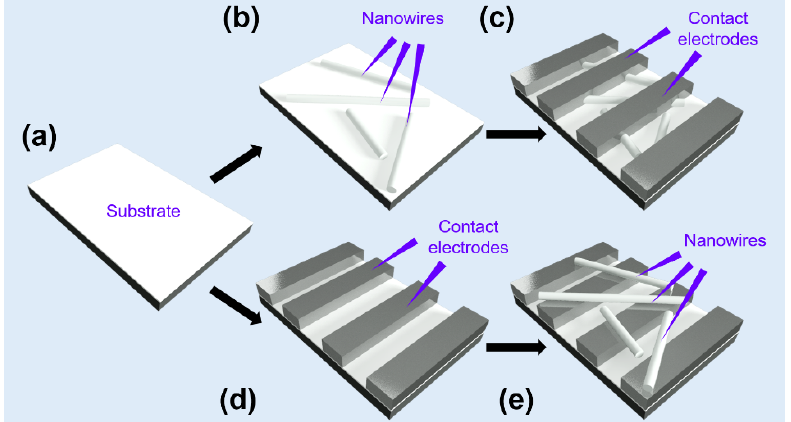
Figure 15. Two typical methods for making a mat-like metal–oxide nanowires device: ( a ) platform; ( b ) nanowires transferred onto the platform; ( c ) contact electrode deposition; ( d ) contact electrode deposition; and ( e ) nanowires transferred onto the platform.